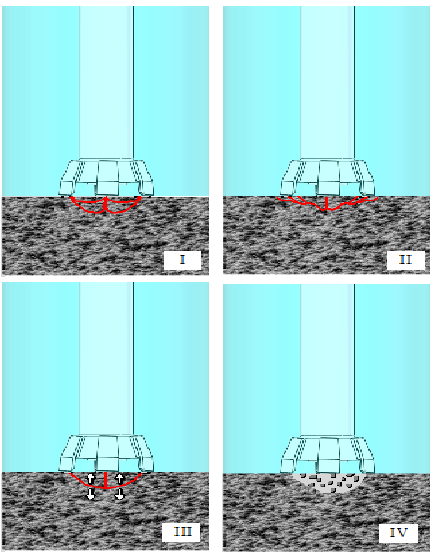
Figure 1. Rock-breaking process of high-voltage EPB: I electric breakdown of rock; II formation of discharge precursor; III formation of main discharge channel; IV fragmentation of rock.